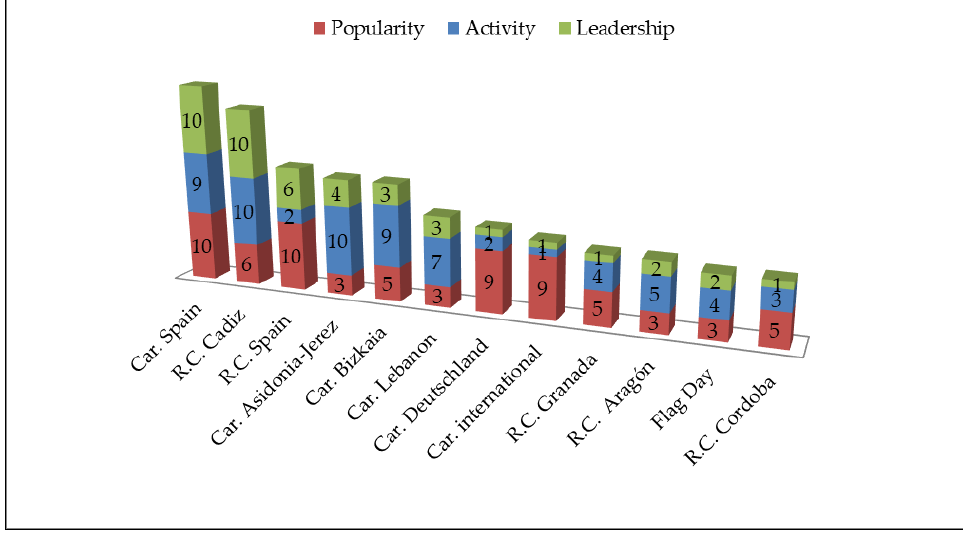
Figure 6. Ranking of pages according to their activity, popularity, and leadership levels.